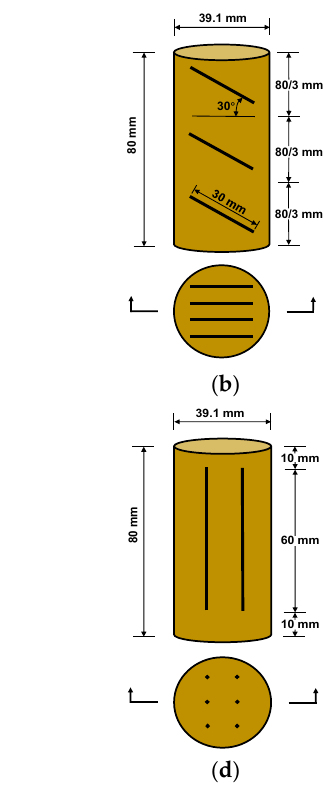
Figure 2. Diagram of the root distribution angles in the triaxial test: ( a ) 0 ◦ , ( b ) 30 ◦ , ( c ) 60 ◦ , ( d ) 90 ◦